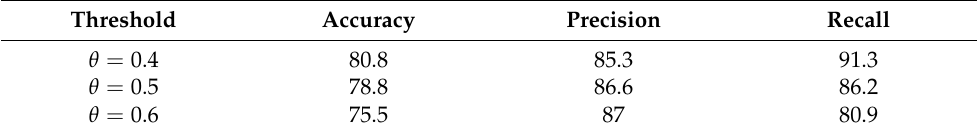
Table 5. Different thresholds of SVM on test set. The default value of the threshold is 0.5. Threshold Accuracy